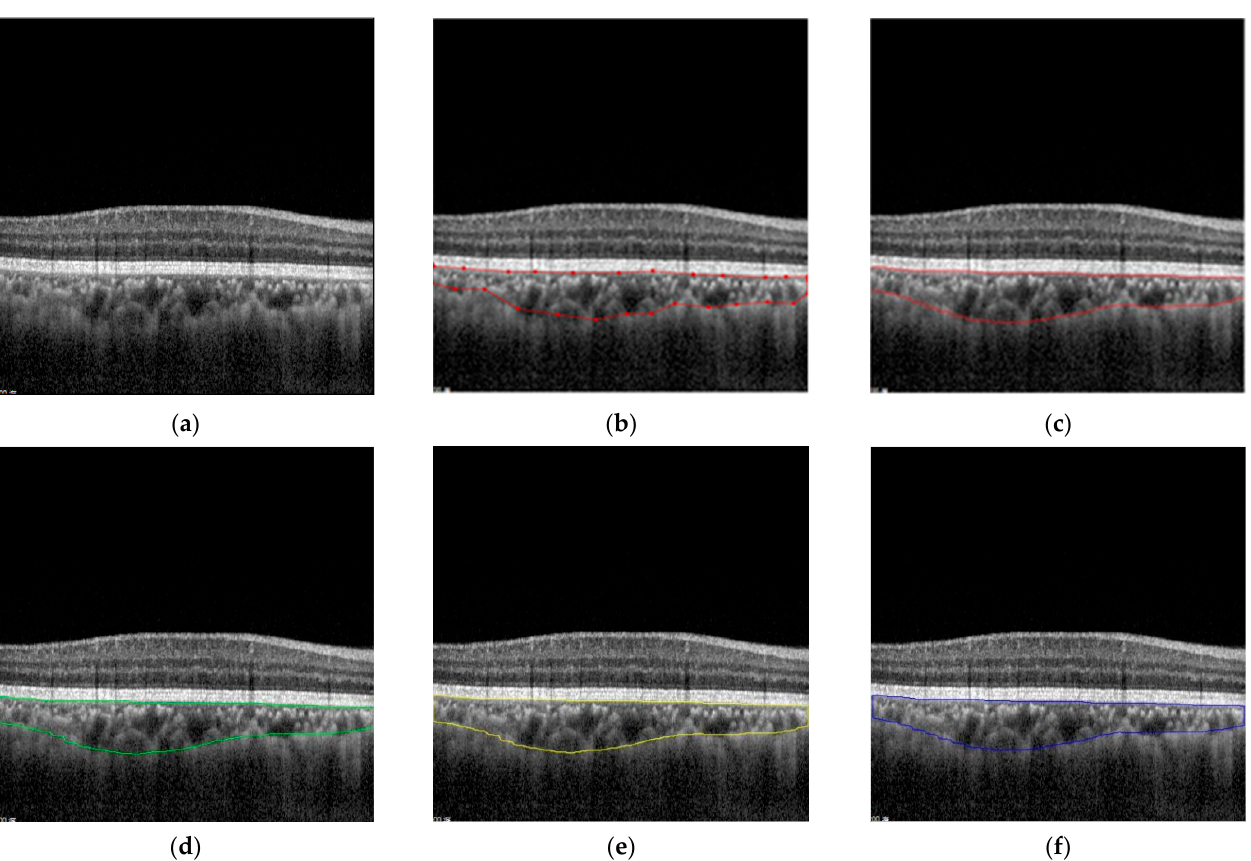
Figure 6. ( a ) Automatic sketching result; ( b ) doctor sketching result; ( c ) combination of Figure 6a,b for comparison of sketching contour by the proposed model and physicians; ( d ) the blue spots show accuracy rates of each case with different choroidal thicknesses. The yellow line shows the average accuracy rate of all 30 cases with the value of 87.5%. The red line shows the average accuracy rate of residual 27 cases with the value of 90.2%, after excluding three cases (case 4, case 24 and case 26) with relative lower accuracy rate due to various influence factors.